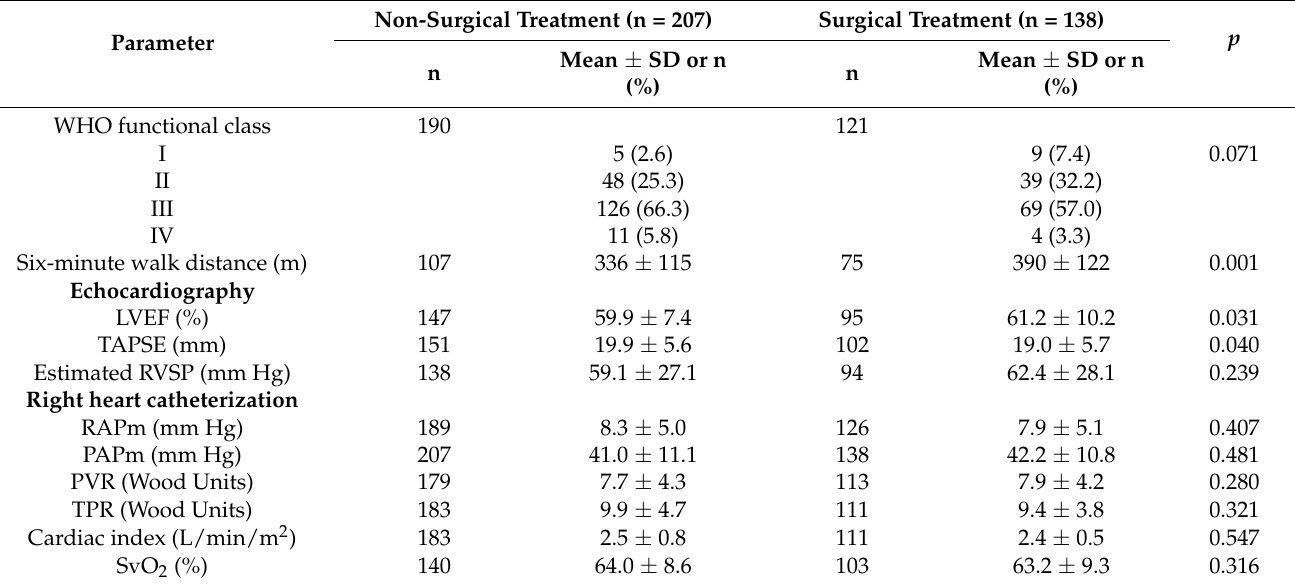
Table 2. Functional Capacity, Echocardiography, and Hemodynamic